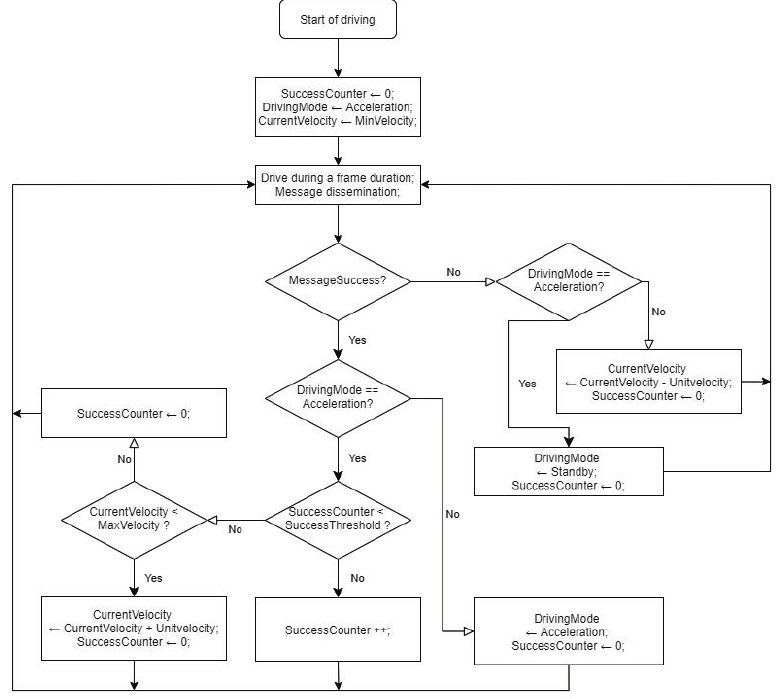
Figure 4. Block diagram of the adaptive platoon velocity control